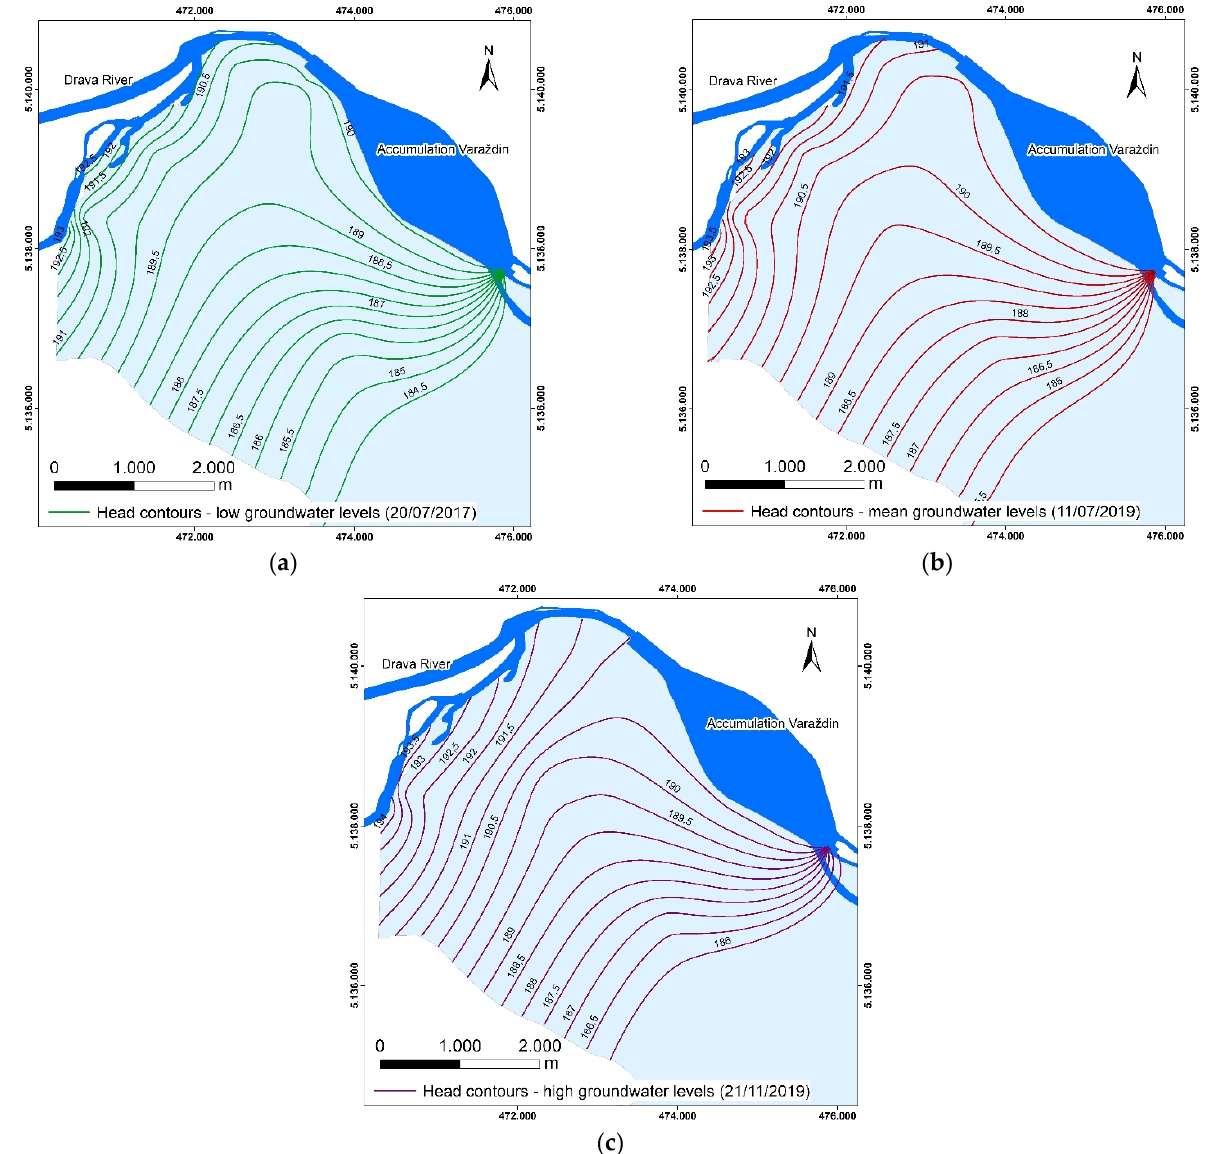
Figure 5. Head contour map for ( a ) low; ( b ) mean; ( c ) high groundwater levels.